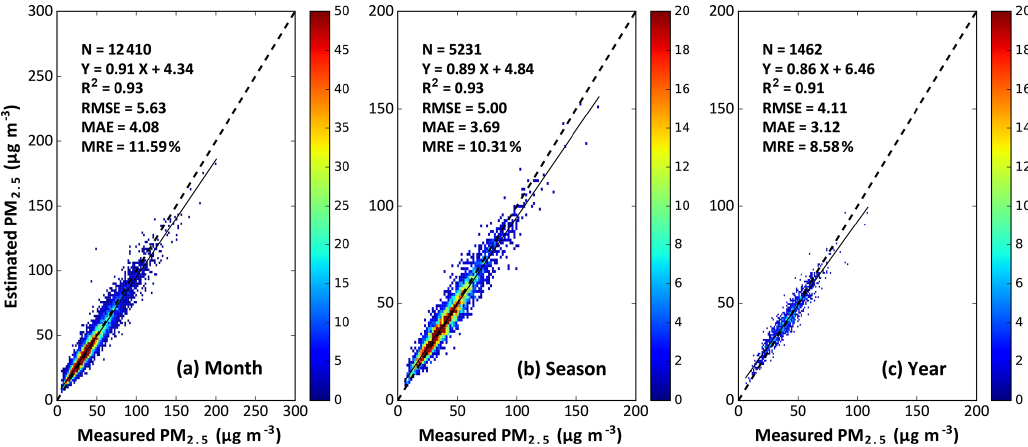
Figure 10. Validation of (a) monthly, (b) seasonal and (c) annual PM 2 . 5 estimates in 2018 in China. Statistical metrics are given in each panel, along with the linear regression relation, including the number of samples ( N ), the correlation of determination ( R 2 ), the root-mean-square error (RMSE), the mean absolute error (MAE) and the mean relative error (MRE).